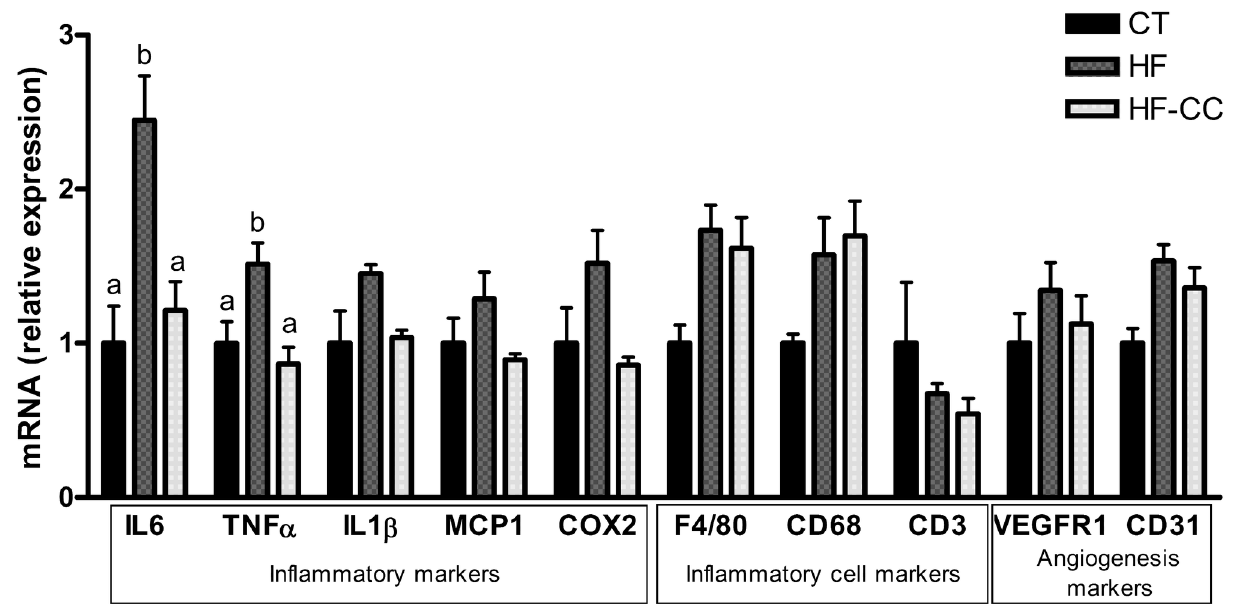
Figure 2. mRNA levels of key markers in subcutaneous adipose tissue. Mice were fed a high fat diet (HF) or a high fat diet supplemented with Curcuma-P® (HF-CC) for 4 weeks. Values are expressed relative to controls (set at 1). Data with different superscript letters are significantly different at p<0.05, according to the post hoc ANOVA statistical analysis.